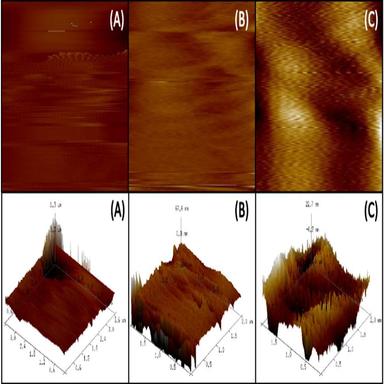
2D and 3D AFM images of (A) GLT film, (B) GLT/Neem extract film, (C) GLT/Neem extract NCP film.